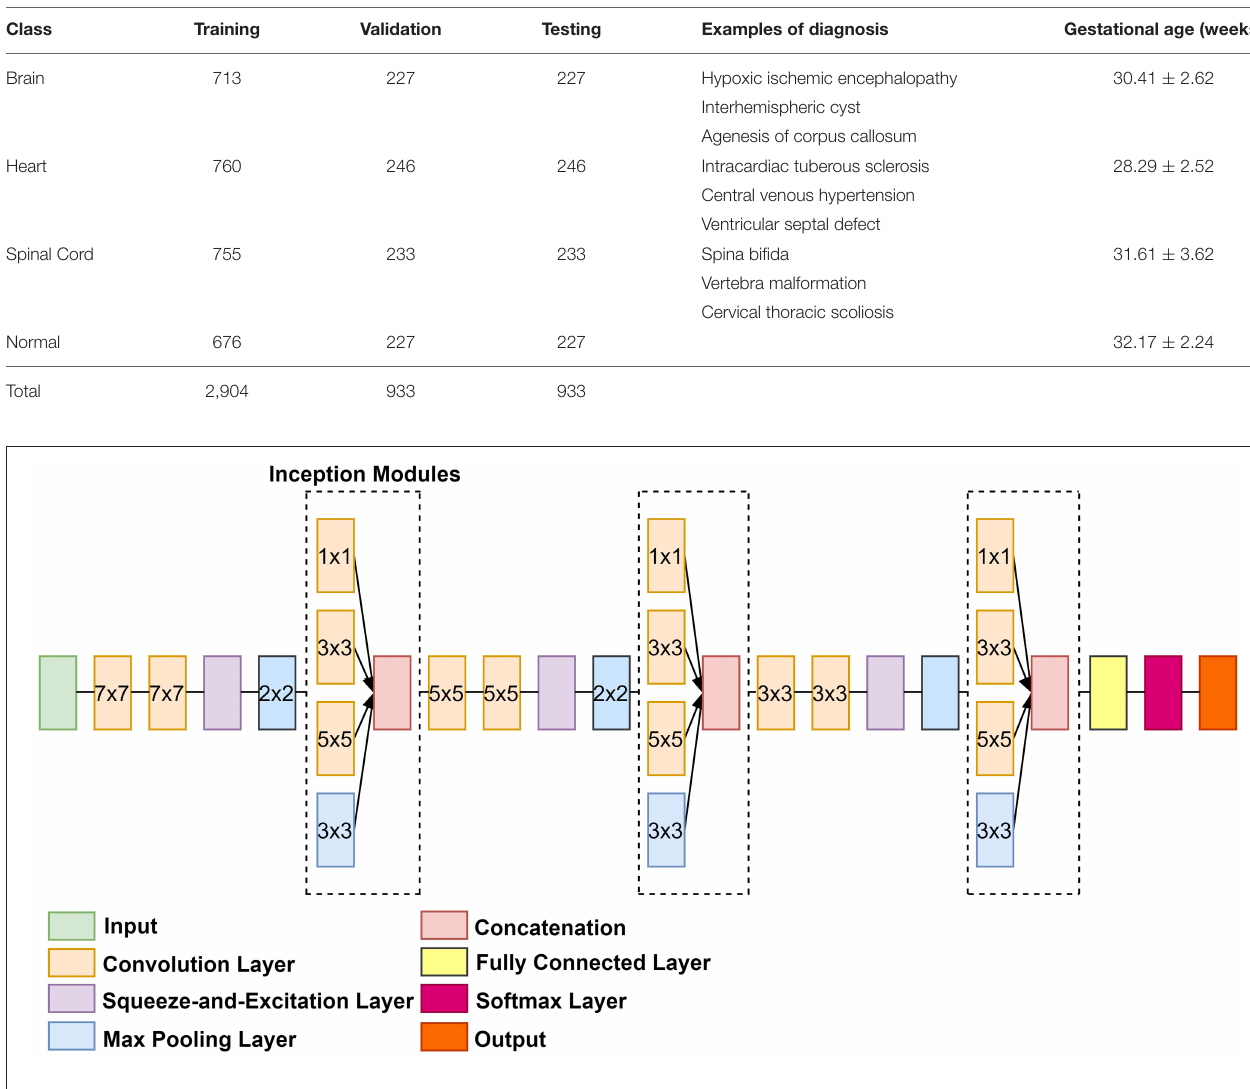
main cohorts: (1) brain abnormality, (2) cardiac